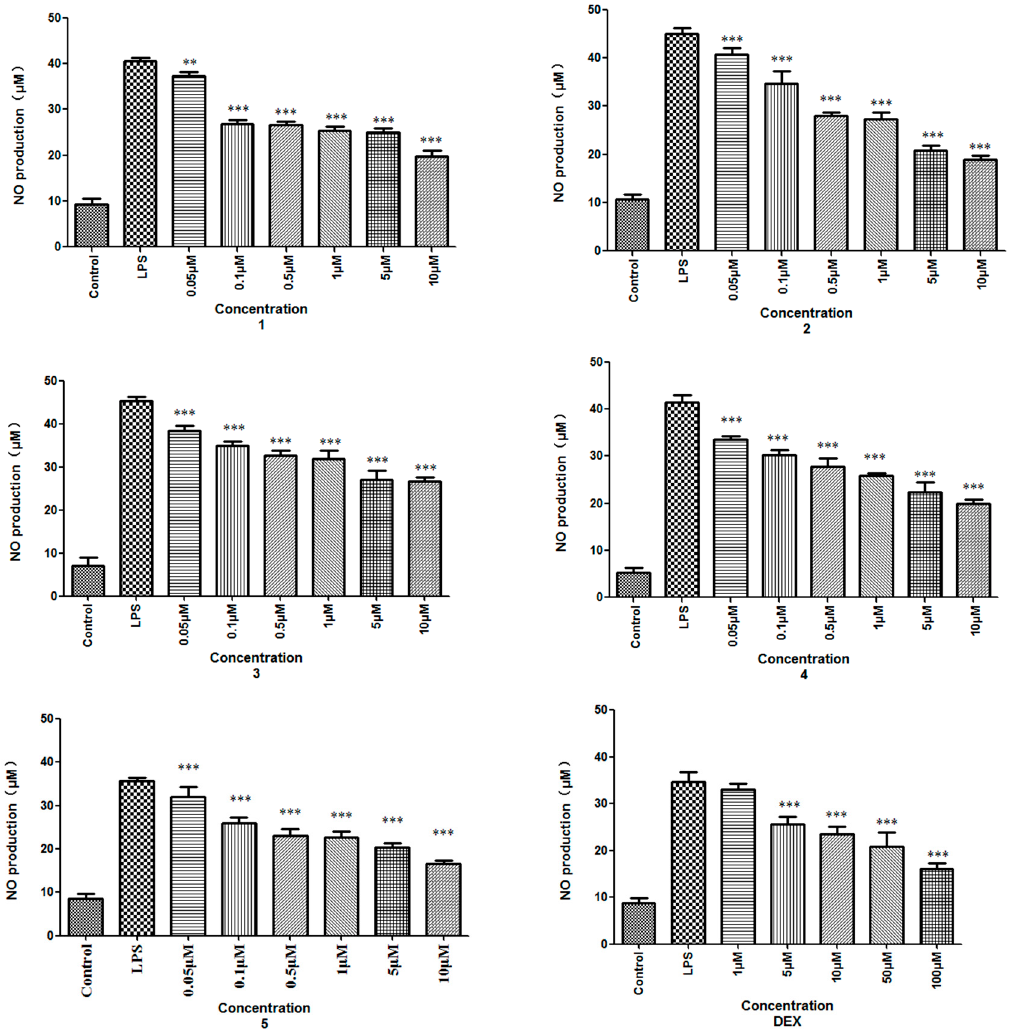
Figure 5. NO inhibitory effects of compounds from A. szechenyianum on LPS-activated RAW264.7 cells. Results represent the mean ± SD of three independent experiments; results differ significantly from the LPS-treated, ** p < 0.01, *** p < 0.001; dexamethasone (DEX) was used as a positive control.